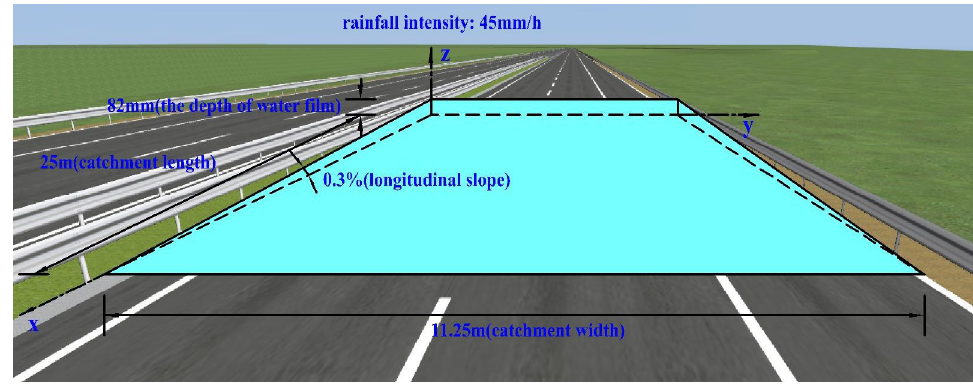
Fig 11. Schematic of the water film depth (Model B).